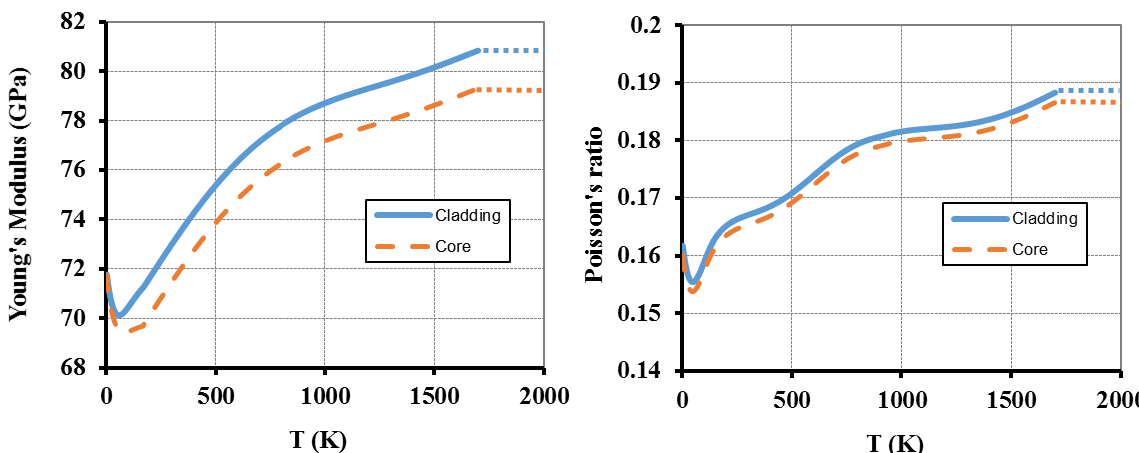
Figure 3. Variation of Young’s module and Poisson’s ratio for both fused silica (from COMSOL materials library) cladding and Ge-doped fused silica (extrapolated) core glasses.